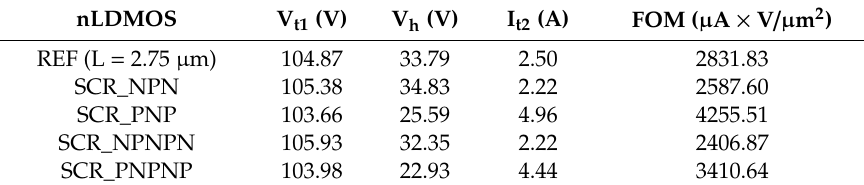
Figure 15. Snapback I-V curves and leakage currents of HV nLDMOSs with embedded SCR modulation. Table 4. Snapback extracted parameters of HV nLDMOSs with embedded SCR modulation.